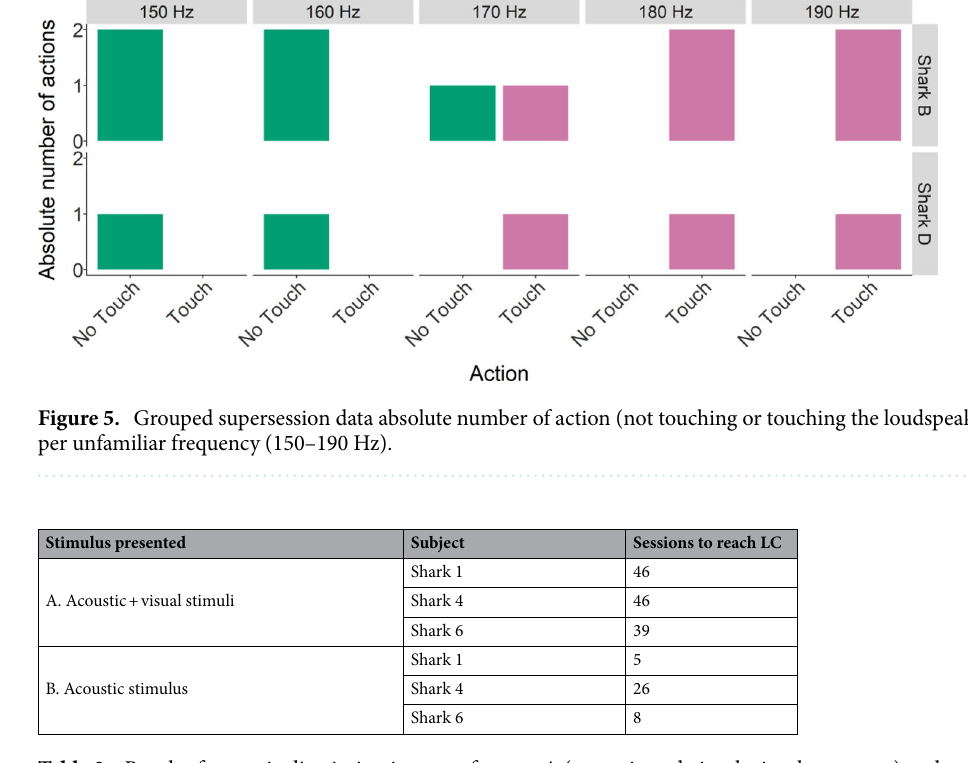
Table 3. Result of acoustic discrimination tests for part A (acoustic and visual stimulus present) and part B (acoustic stimulus present) in juvenile bamboo sharks. Number of sessions needed to reach the learning criterion (LC: 70% correct choices in five consecutive sessions) and average loudspeaker touch (LST) times [s]. Note that the average times are the same for part A and B.